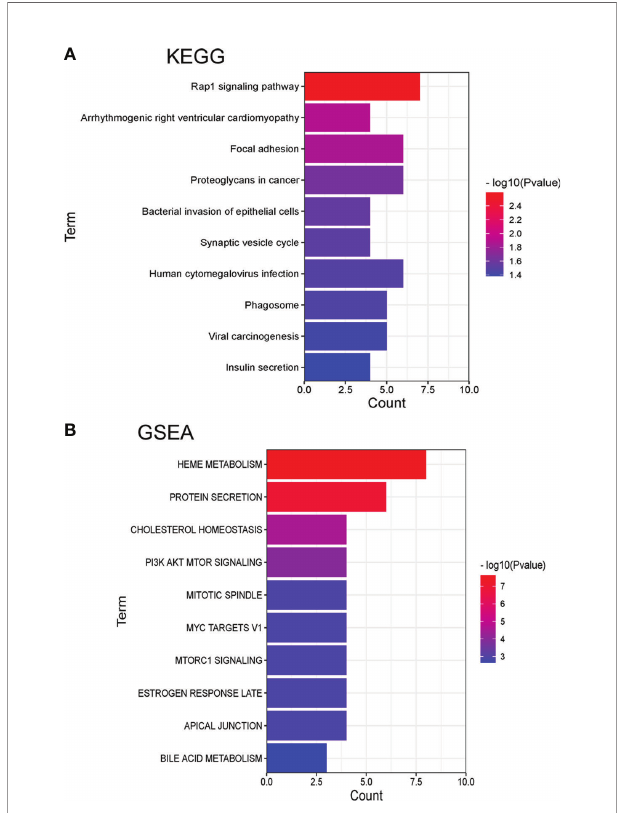
FIGURE 5 | Pathway enrichment analysis of KEGG and GSEA with identi fi ed differently expressed ubiquitinated proteins (top 10). (A) Pathways by KEGG. (B) Pathways by GSEA.